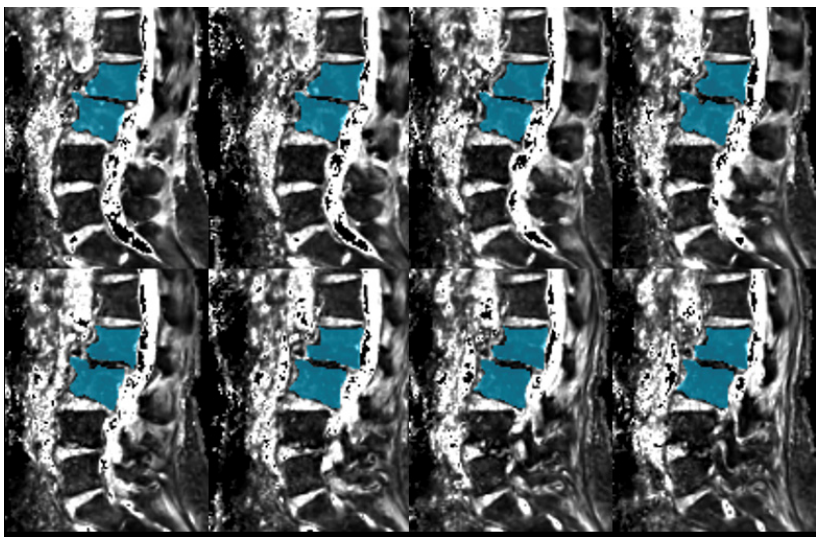
Figure 2. The region of interest for measuring T2* values and PDFF. The entirety of the two vertebrae showing Modic changes was set as the region of interest (blue color regions) when measuring T2* values and PDFF.